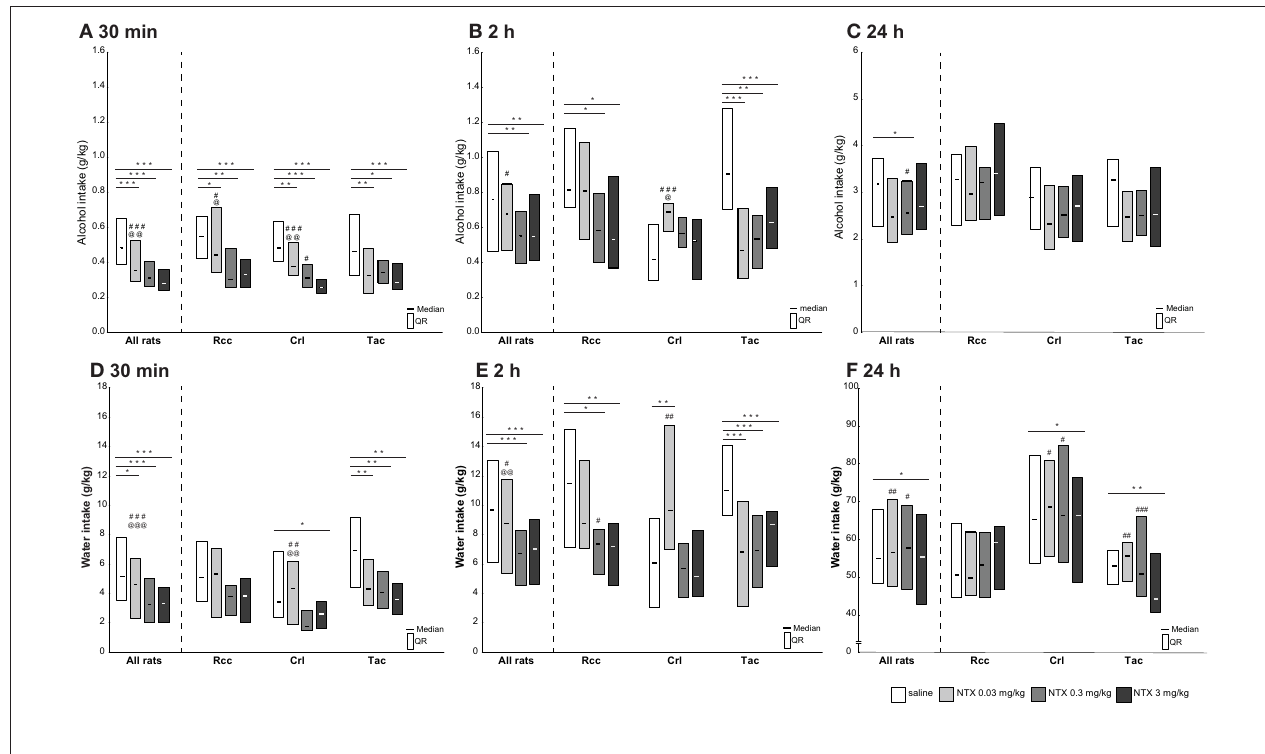
FIGURE 5 | Voluntary alcohol (A–C) and water (D–F) intake (g/kg) after treatment with saline or naltrexone (0.03, 0.3, or 3mg/kg) administered s.c. 30min prior to alcohol access in Wistar rats from three different suppliers, i.e., RccHan TM :WI (Rcc), Crl:WI (Crl), and HanTac:WH (Tac). Alcohol and water intake was measured at 30min ( A,D , respectively), 2h ( B,E , respectively), and 24h ( C,F , respectively) after access. Data are presented as median and quartile range. * p ≤ 0.05 , ** p < 0.01 , *** p < 0.001 compared to saline; @ p ≤ 0.05 , @@ p < 0.01 , @@@ p < 0.001 compared to naltrexone at 0.3mg/kg; # p ≤ 0.05 , ## p < 0.01 , ### p < 0.001 compared to naltrexone at 3mg/kg (Wilcoxon matched pairs